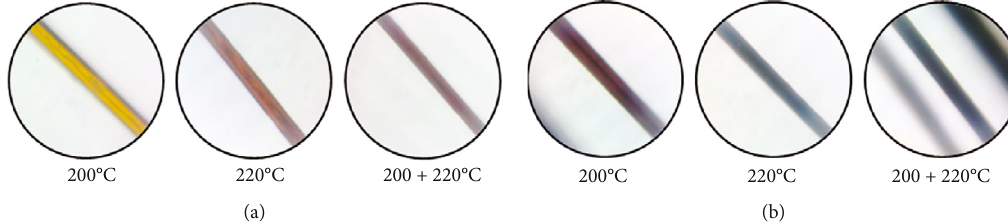
Figure 6: Optical microscopy, longitudinal section of fi bers treated thermally at di ff erent temperatures and times. (a) for FCOM and (b) for